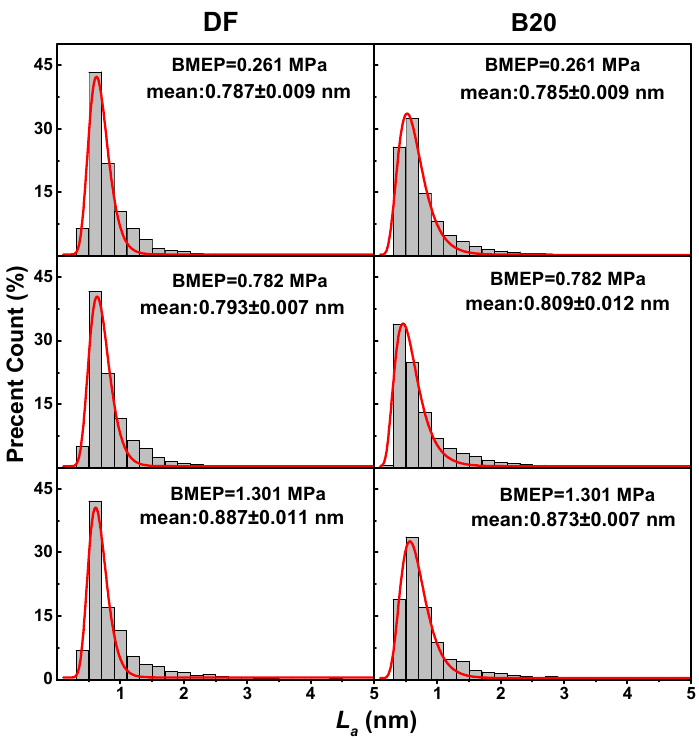
Figure 5. Histograms of fringe length (L a ) data for both DF and B20 soot in the applied test modes.